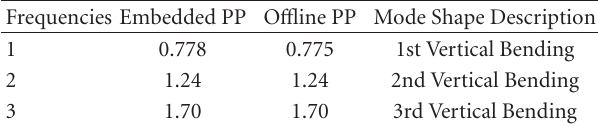
Table 3: Identified vibration frequencies of the Wuyuan Bridge in vertical bending by the embedded and o ffl ine PP analysis.